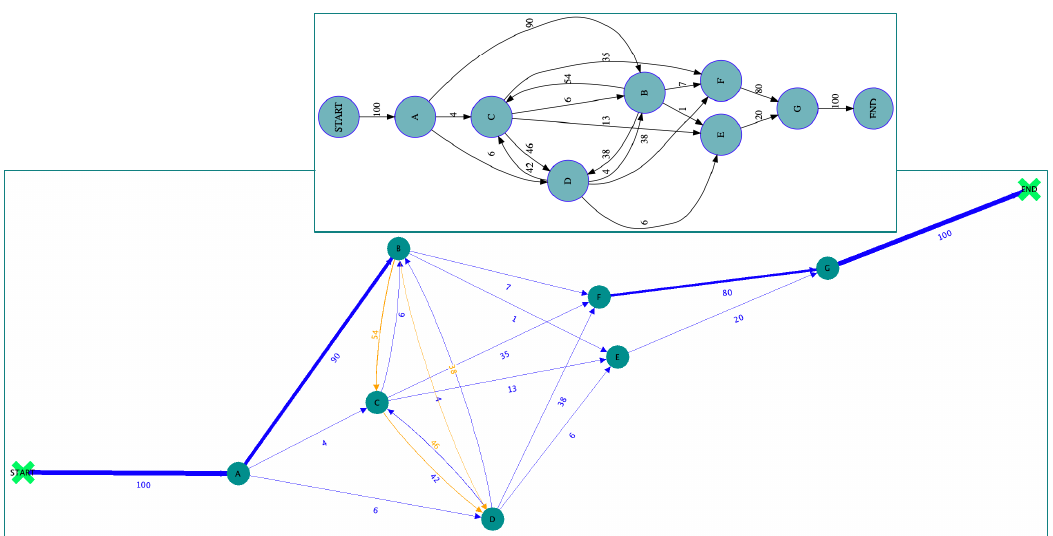
Figure 13. The behavioral sequence net rediscovered from the Experimental Dataset-2. Table 2. The behavioral sequence (BS) analysis results on the Experimental Dataset-2. BS Species